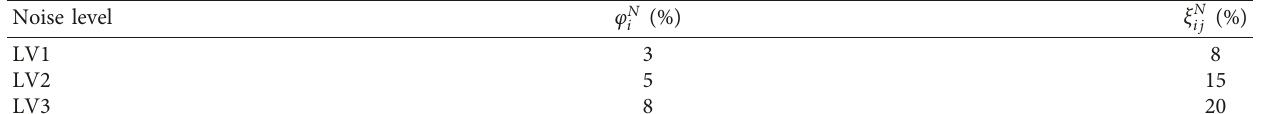
Table 6: Different noise levels.